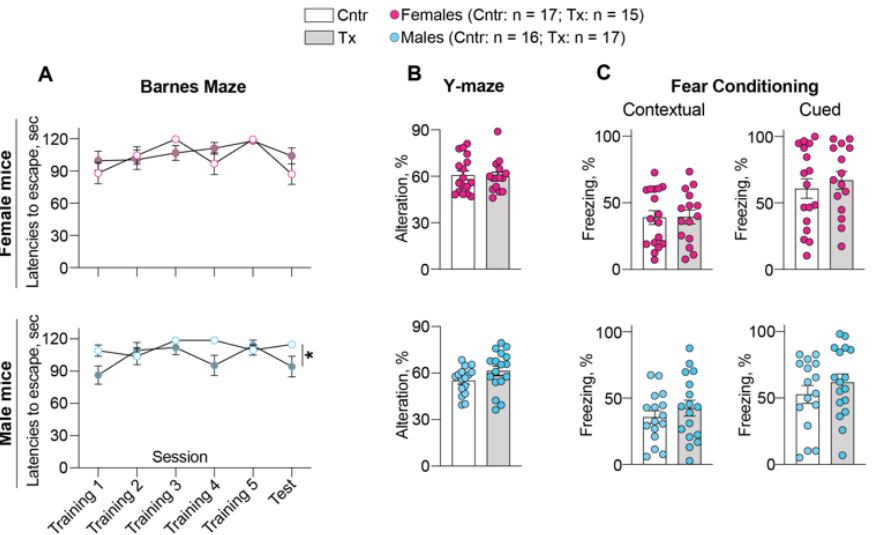
Figure 3. 8,14-DihydroxyEFV effect on performance of 5XFAD mice in behavioral tasks: ( A ), Barnes Maze test; ( B ), Y-maze test; and ( C ), fear conditioning tests. Data represent the mean ± SEM of the measurements in individual mice (17 control female mice, 15 treated female mice, 16 control male mice, and 17 treated male mice). Statistical significance was assessed by two-way repeated measures ANOVA with Bonferroni correction (the Barnes Maze test) and a two-tailed unpaired Student’s t -test (the Y-maze test and fear conditioning tests). * p = 0.03 was only detected between the session number and treatment factor in the Barnes maze test for male mice. Cntr, control mice; Tx, treated mice.